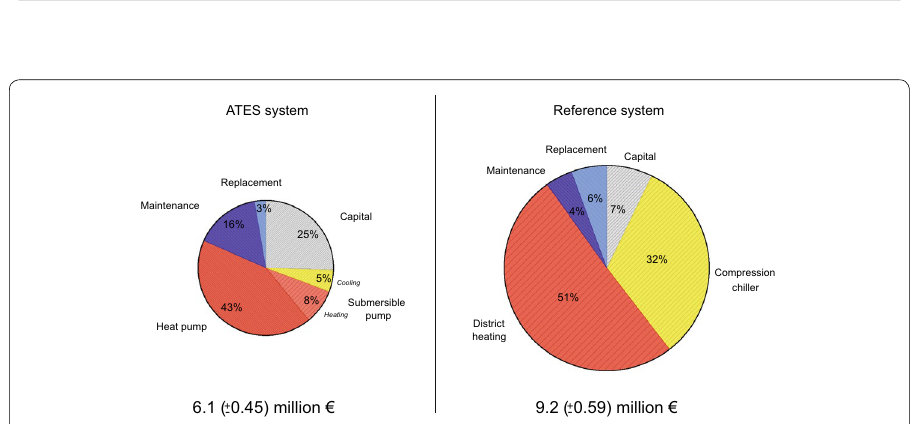
Fig. 7 Comparison of the relative structure of the total costs of the ATES system and the reference system after 30 years of